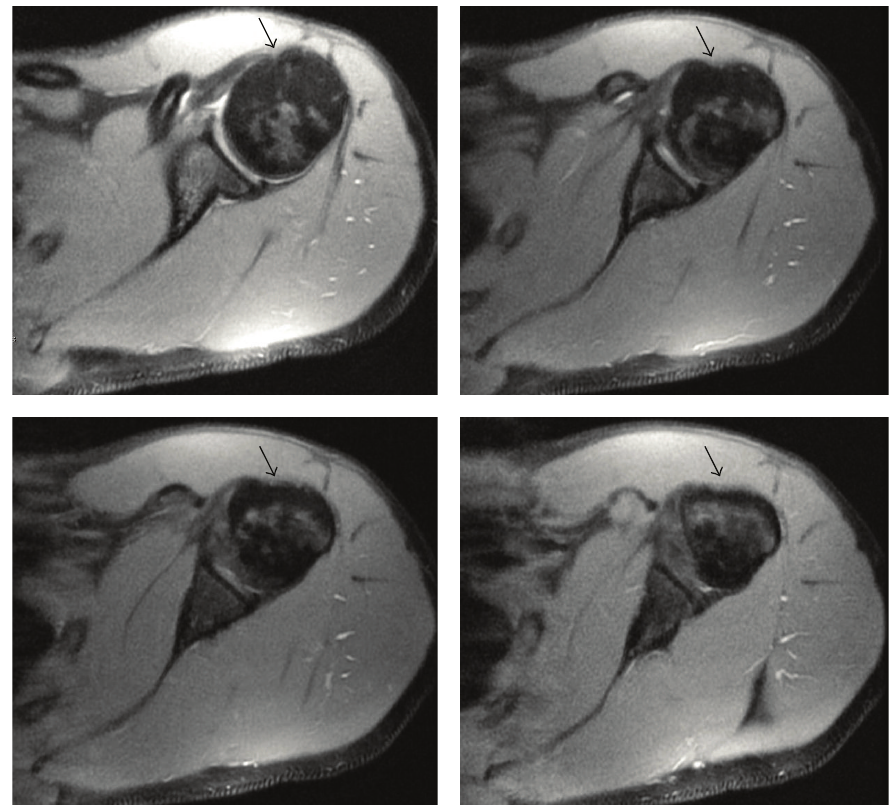
Figure 3: Axial DP FS SE MR sequential images of the left shoulder (TR = 2540; TE = 11.18; NEX = 2; EC = 1) showing a shallow bicipital groove (black arrows) and absence of the long head of the biceps tendon.